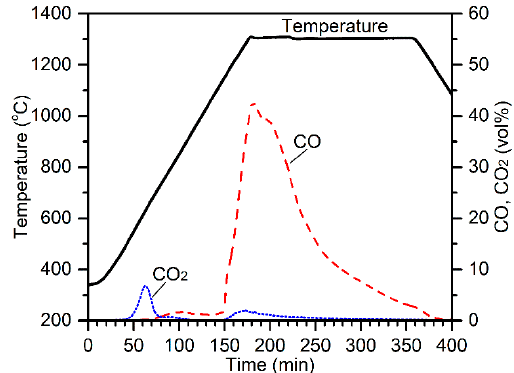
Figure 10. Temperature profiles and off-gas CO and CO 2 concentrations for the test using petroleum coke as the reductant.